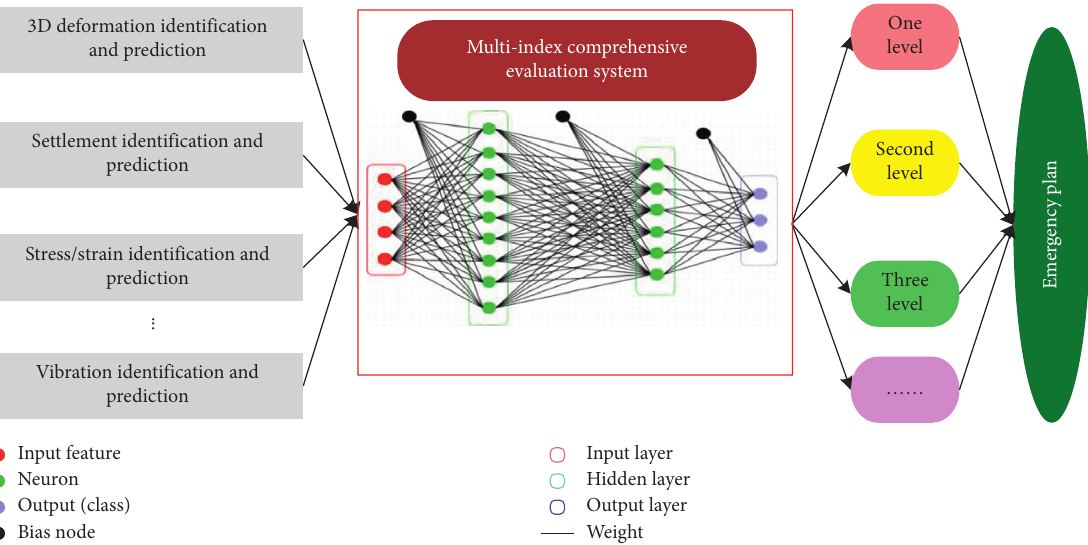
Figure 9: Classified early warning and emergency